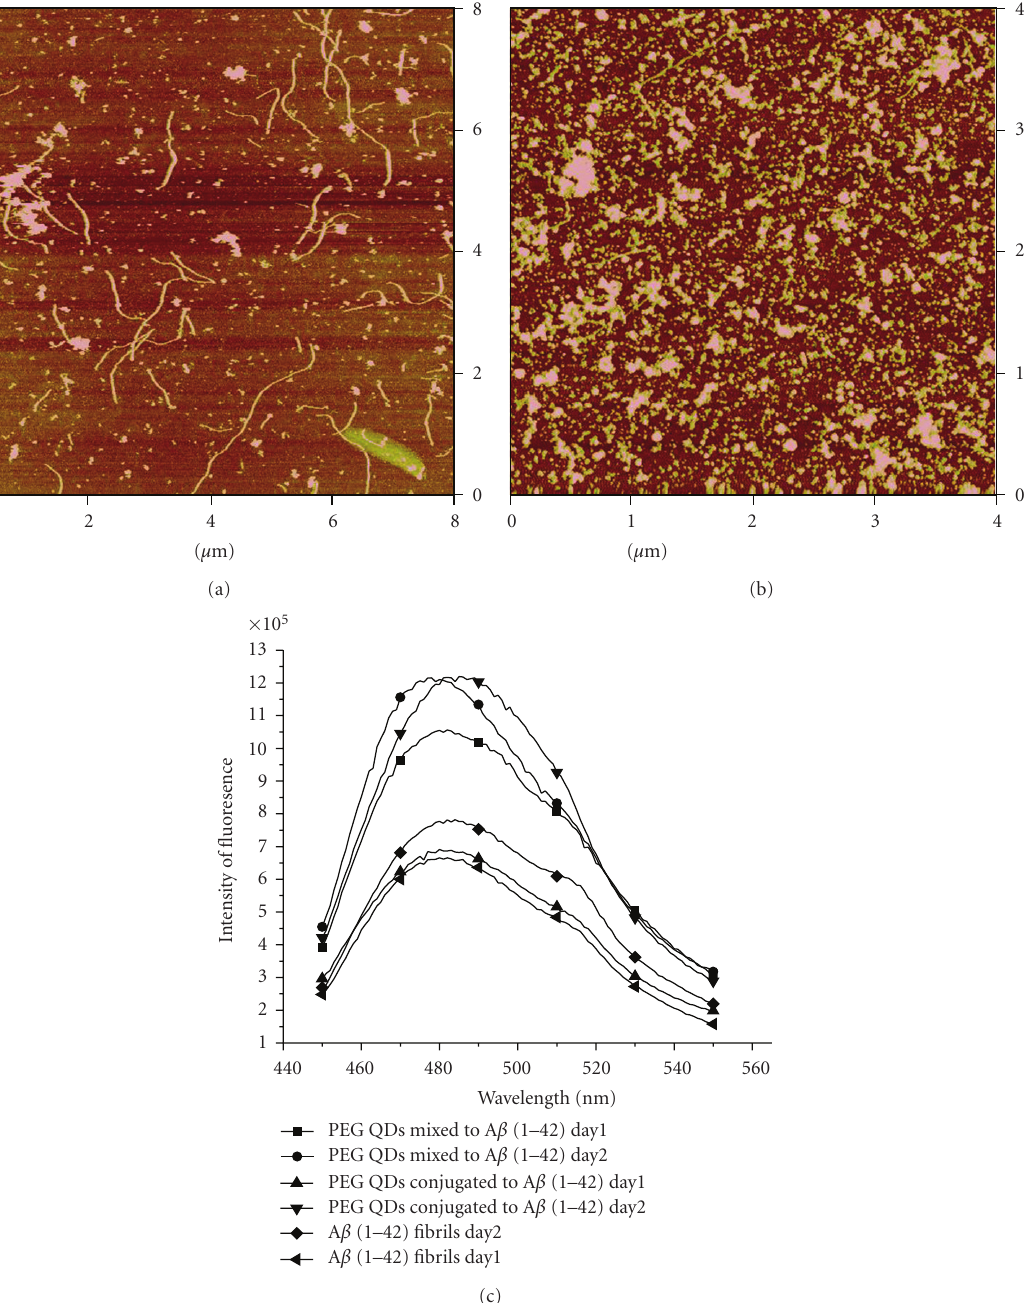
Figure 10: AFM image of (a) PEG-capped QDs conjugated with A β (1–42) in PBS bu ff er (pH 7.4), 8 μ m × 8 μ m; (b) PEG-capped QDs mixed with A β (1–42) in PBS bu ff er (pH 7.4), 4 μ m × 4 μ m; (c) comparison of ThT fluorescence for 2 days for PEG-capped QDs mixed and conjugated with A β (1–42) and pure A β (1–42)